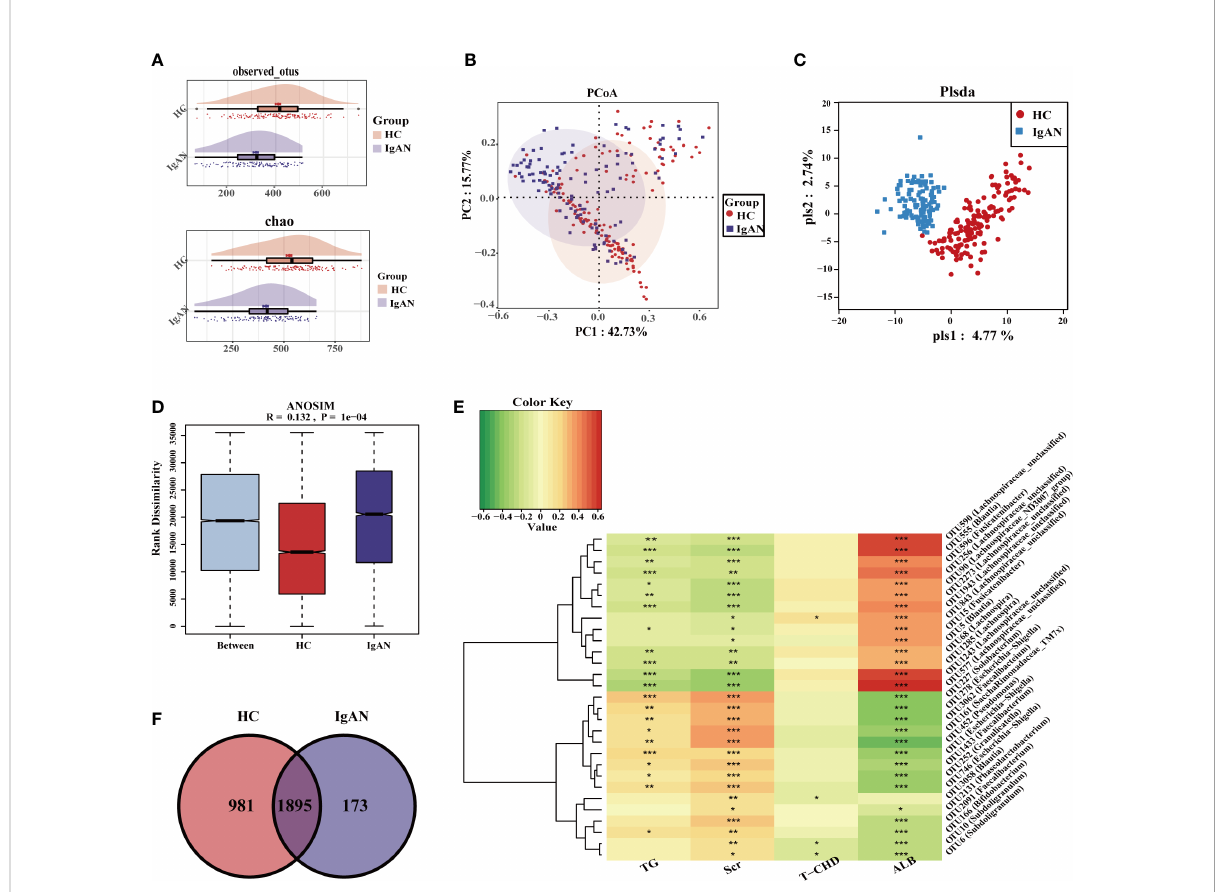
FIGURE 3 Gut microbiome composition differences at OUT level in HC and IgAN. (A) Observed OTUs and chao index were decreased in IgAN. (B) Two- dimensional PCoA based on weighted UniFrac distance between HC and IgAN. (C) PLSDA graph of the composition of gut microbiota in HC and IgAN. (D) ANOSIM results indicated that whether the difference between groups and within groups were statistically different. P < 0.05 indicates that the statistics are signi fi cant. (E) A Venn diagram based on the distribution of intestinal microbe OTUs in two groups. (F) Spearman correlations between different OTUs and clinical indicators. Red represented a positive relationship, and green represented a negative relationship. The darker the color, the stronger the correlation. The correlation with signi fi cant difference is indicated by an asterisk(* P < 0.05; ** P < 0.01; *** P < 0.001). OTUs, Operational Taxonomic Units; PCoA, Principal Coordinates Analysis; PLSDA, partial least squares discriminant analysis; ANOSIM, analysis of similarity; TG, triglycerides; Scr, Serum creatinine; T-CHO, total cholesterol; ALB, serum albumin; HC, healthy controls; IgAN, immunoglobulin A